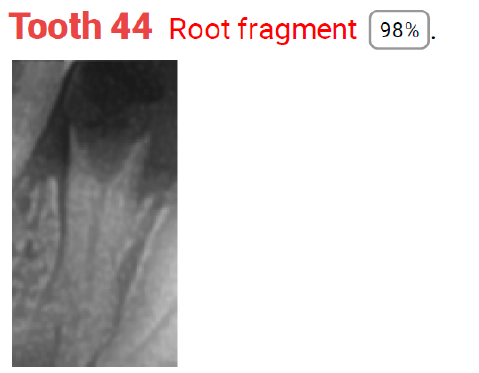
Figure 2. Diagnocat report, with missing detection of cyst connected with tooth 44, and automating caption of tooth recognized as a root fragment.